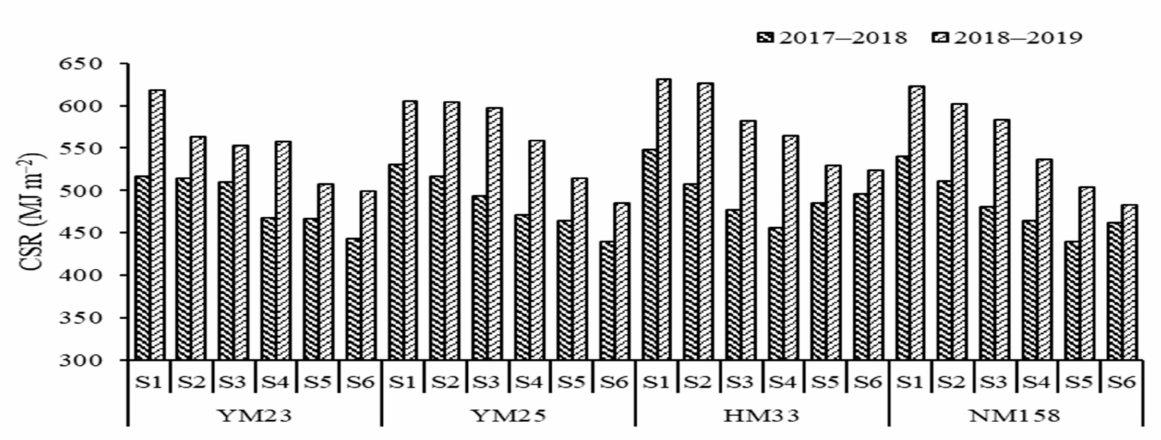
Figure 8. Change in cumulative solar radiation (CSR) after anthesis on different sowing